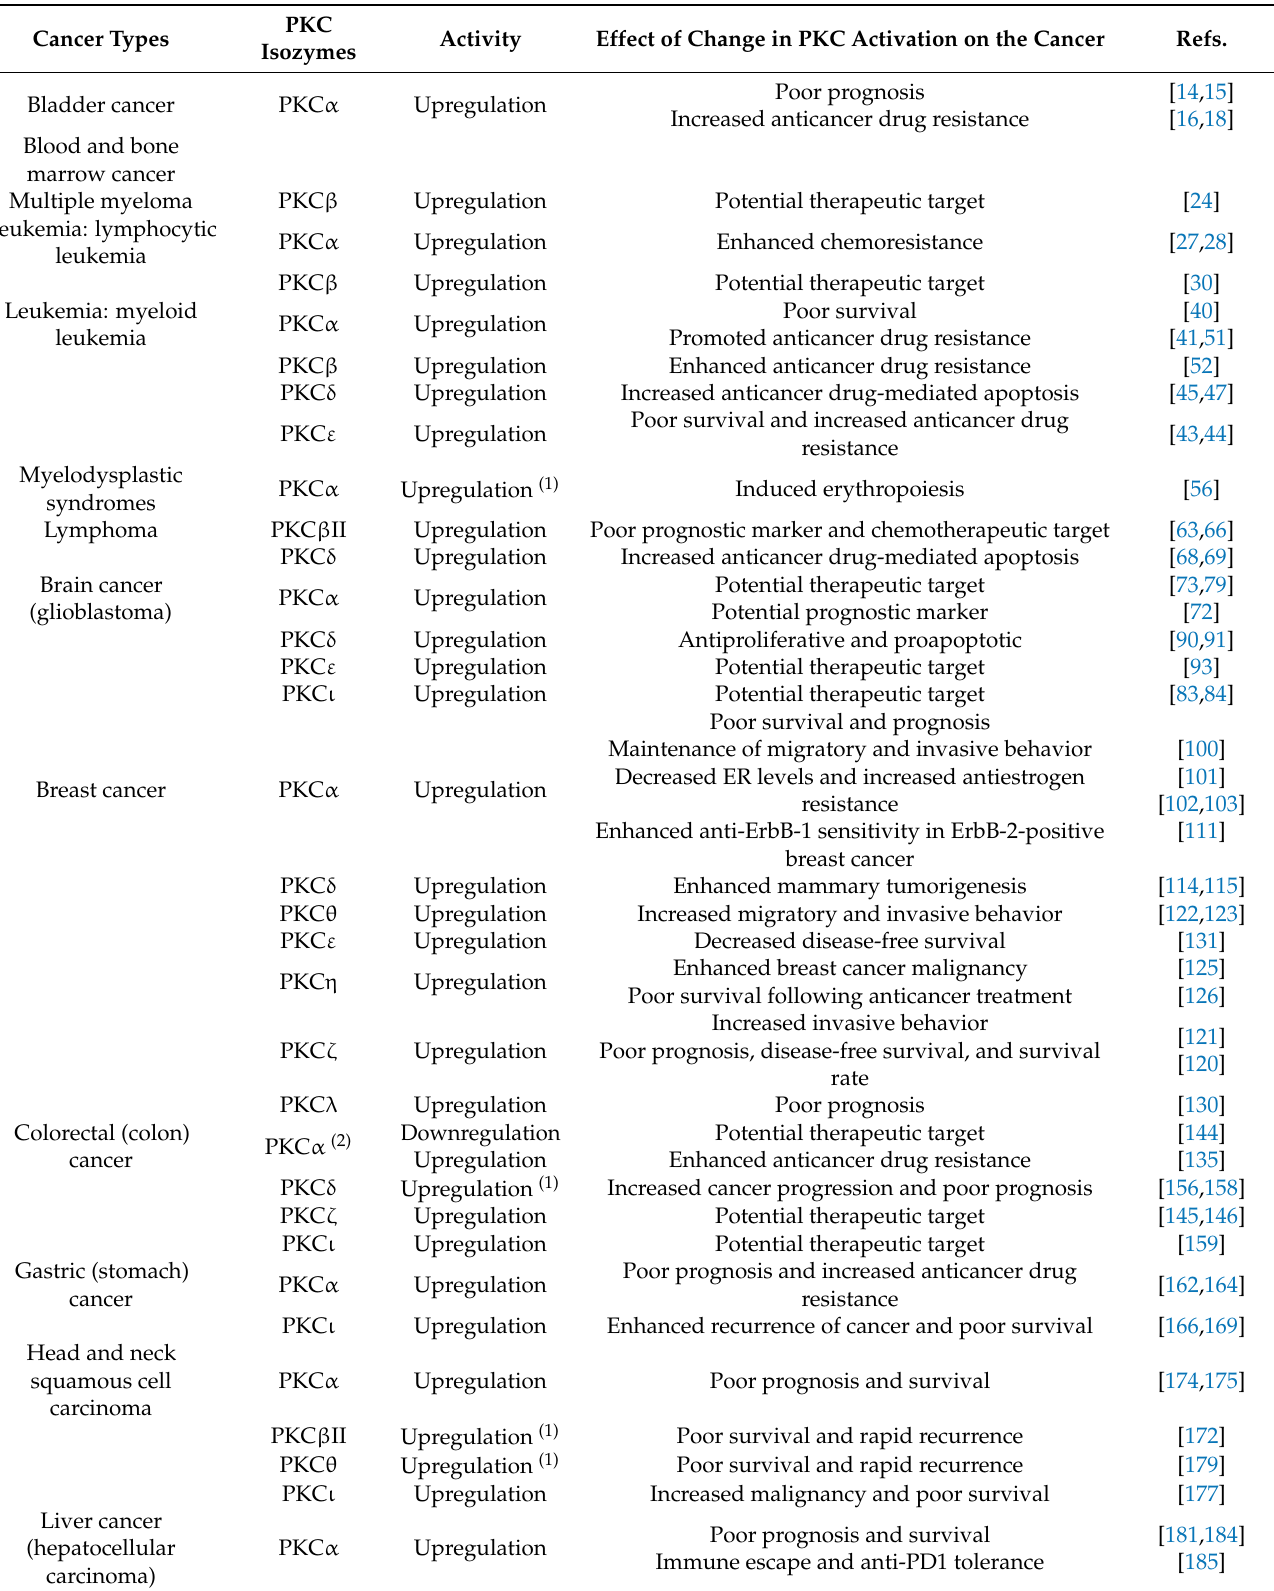
Table 1. PKC isozymes as diagnostic and prognostic biomarkers and therapeutic targets in various cancer